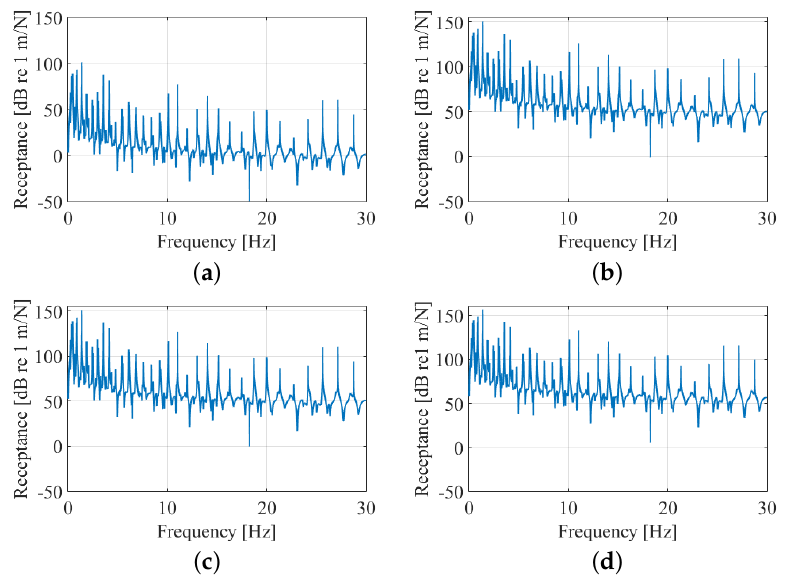
Figure 13. Cable receptances obtained over a meter of cable from the support excited by ( a ) distributed unitary load; ( b ) distributed wind excitation with a base speed of 20 m/s; ( c ) distributed rain load with an intensity of 150 mm/h, and ( d ) distributed wind and rain.